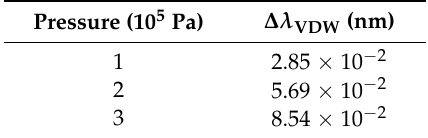
Table 4. Theoretical VDW width for He I at 492.1931 nm for three values of